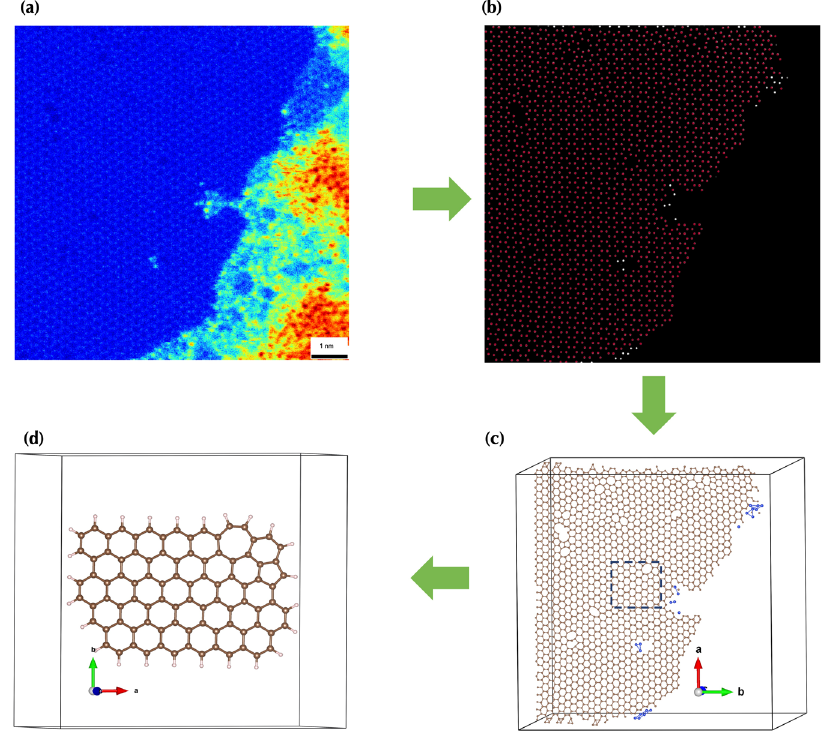
Fig. 3 Obtaining simulation boxes from STEM image. Figure shows a STEM image frame ( a ) of graphene, all C atoms, and defects (Si) as recognized by DCNN ( b ), corresponding simulation object ( c ), and an example patch (identi fi ed region of interest) used ( d ) to perform DFT and AIMD simulations. The blue atoms represent Si atoms, and the brown ones are C atoms. Here, we note that some atomic species got misclassi fi ed but it did not affect the work fl ow since we cropped the high-certainty (and correctly classi fi ed) region. This is somewhat expected during the actual real-time deployment of the work fl